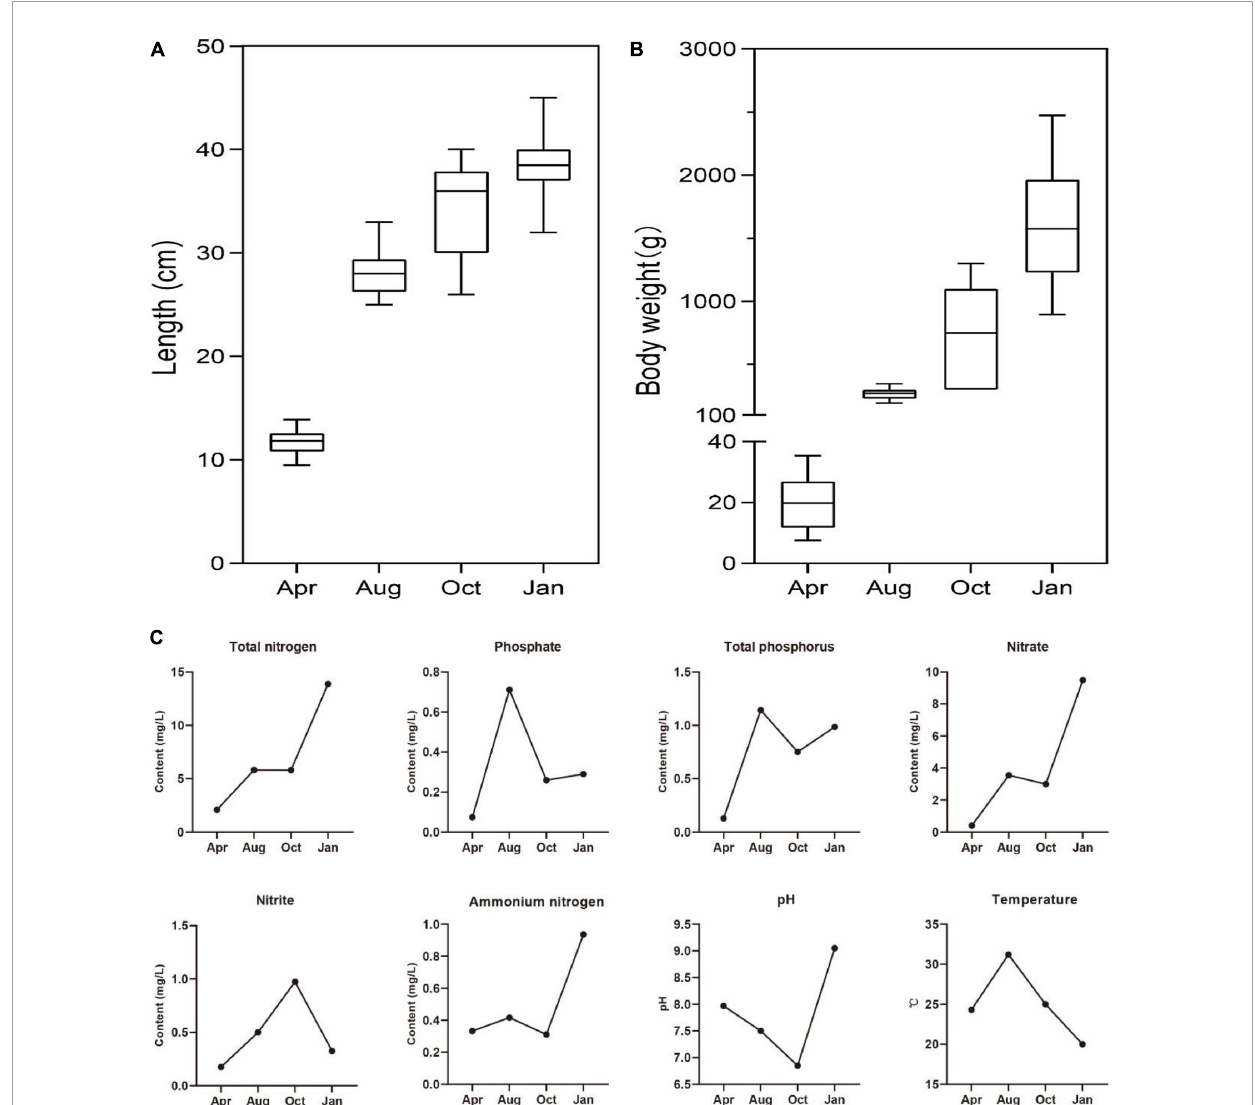
FIGURE1 The growth status of farmed sea bass and the physicochemical factors of water. (A) The changes of sea bass body length. (B) The changes of sea bass body weight. (C) The changes of total phosphorus, phosphate, total nitrogen, nitrate, nitrite, ammonium nitrogen, pH, temperature in water.